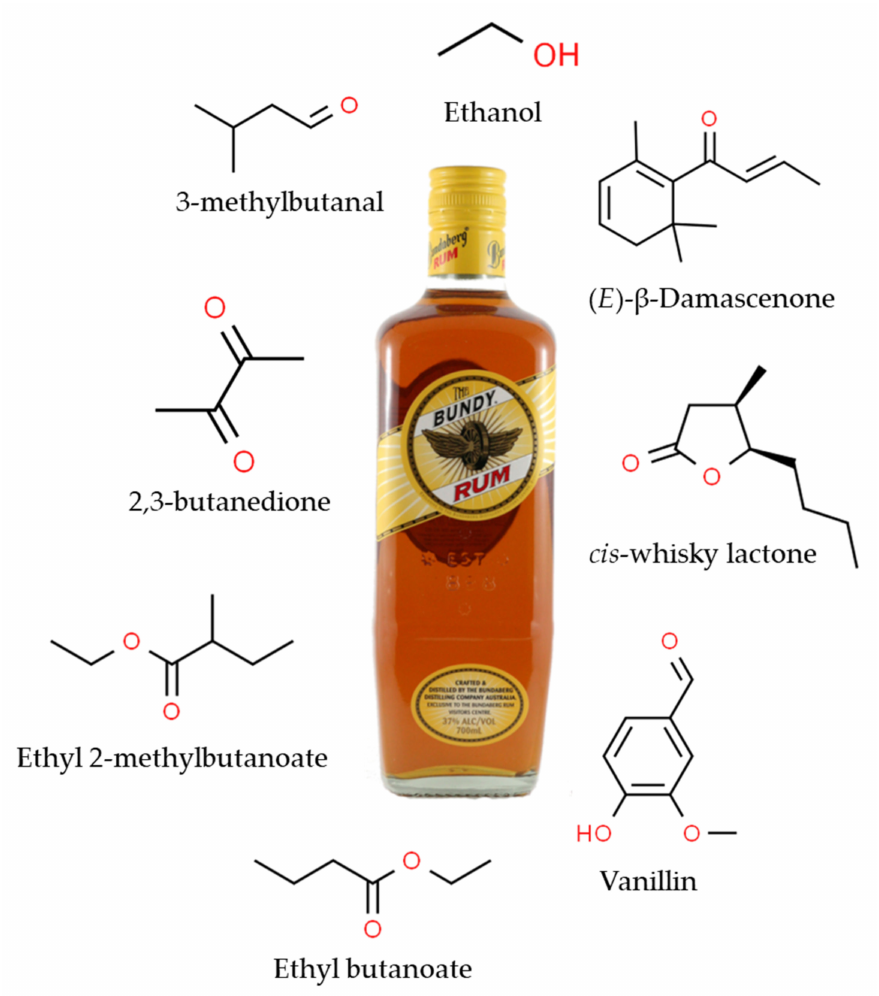
Figure 2. Some of the major flavour-active volatile compounds identified in